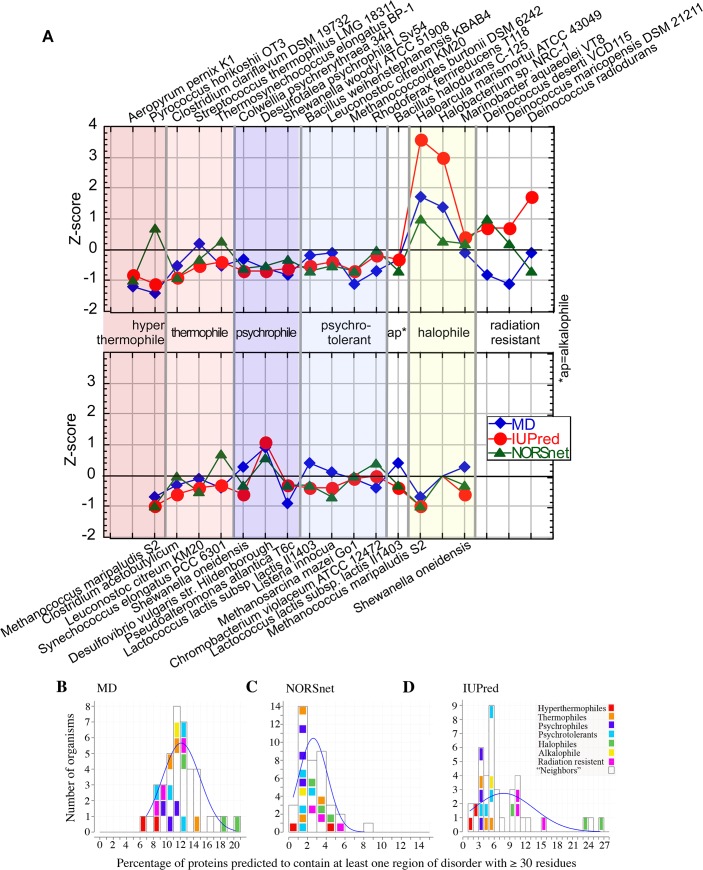
Distribution of disorder content in different organisms.Fractions of proteins with long regions of disorder (here ≥30 consecutive residues) were predicted by three prediction methods (MD, NORSnet and IUPred). (A) The raw values are standardized using the Z-scores (Eq 1; mean and standard deviation σ from a 1613 prokaryotes calculated for each method; positive: higher than the mean; negative: below the mean; integers +/- N imply N*σ above/below the mean). The top panel shows the extremophiles; the lower panel shows the closest phylogenetic relative for each extremophile in the top panel (for relatives discussed in the text and left out for clarity from the figure, for all studied organisms S3 Fig). The archaeal halophiles Haloarcula marismortui ATCC 43049 and Halobacterium sp. NRC-1 were predicted with the highest content of proteins with long disorder. Conversely, the archaeal thermophile Aeropyrum pernix K1 was one of the organisms predicted with the lowest disorder. The taxonomic neighbors section compares the disorder predicted for the closest relatives of the extremophiles. (B-D) Mapping of disorder protein content predictions for all organisms for each prediction method (B: MD [42], C: NORSnet [6], and D: IUPred Clearly, all three methods put the thermophiles on the left (less disorder), while the halophiles appear on the right (high disorder). The blue curves are Gaussian fits based on the mean and σ of our data.